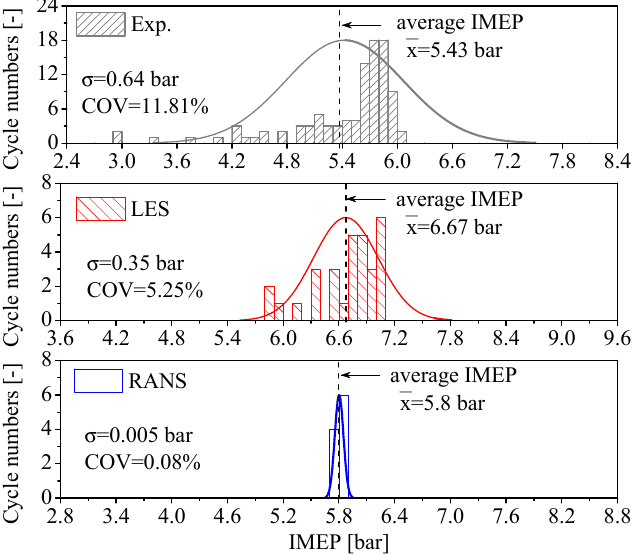
Figure 3. Comparison of the IMEP histograms of the consecutive cycles from experiments, LES and RANS simulations.